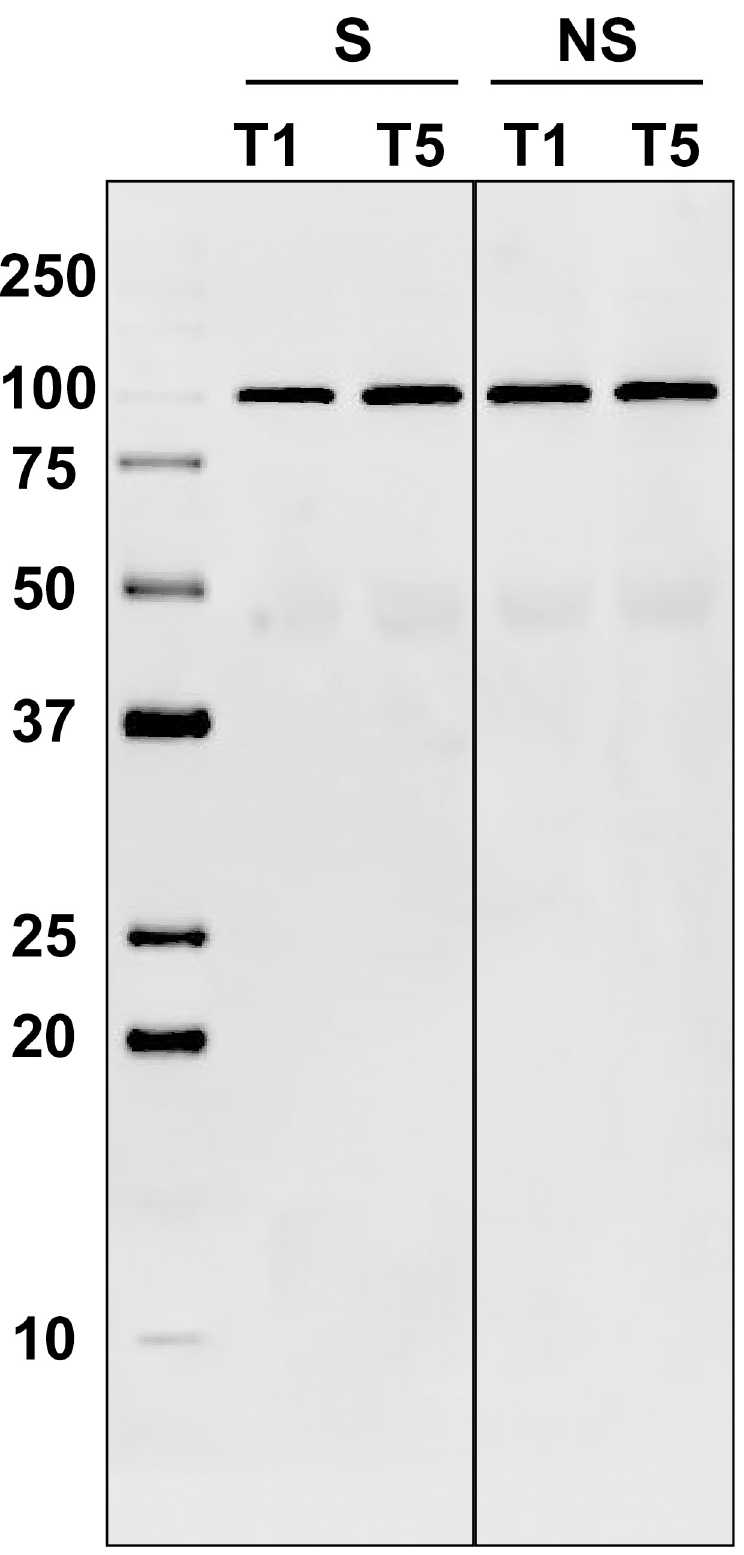
Fig 11. Detection of haptoglobin in the surviving group (L) and adverse outcome group (D) by means of Western blotting. Three time point of each group were compared to illustrate the progression over time ( t 3 ! t 4 ! t 5 ). https://doi.org/10.1371/journal.pone.0222403.g011 PLOS ONE | https://doi.org/10.1371/journal.pone.0222403 September 30,